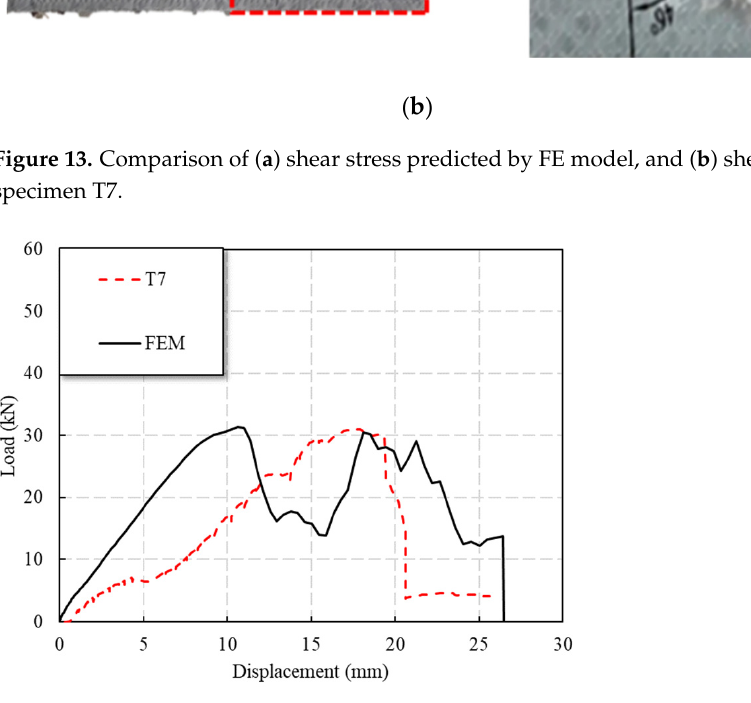
Figure 14. Comparison of FEM and test results of load response of specimen T7 .